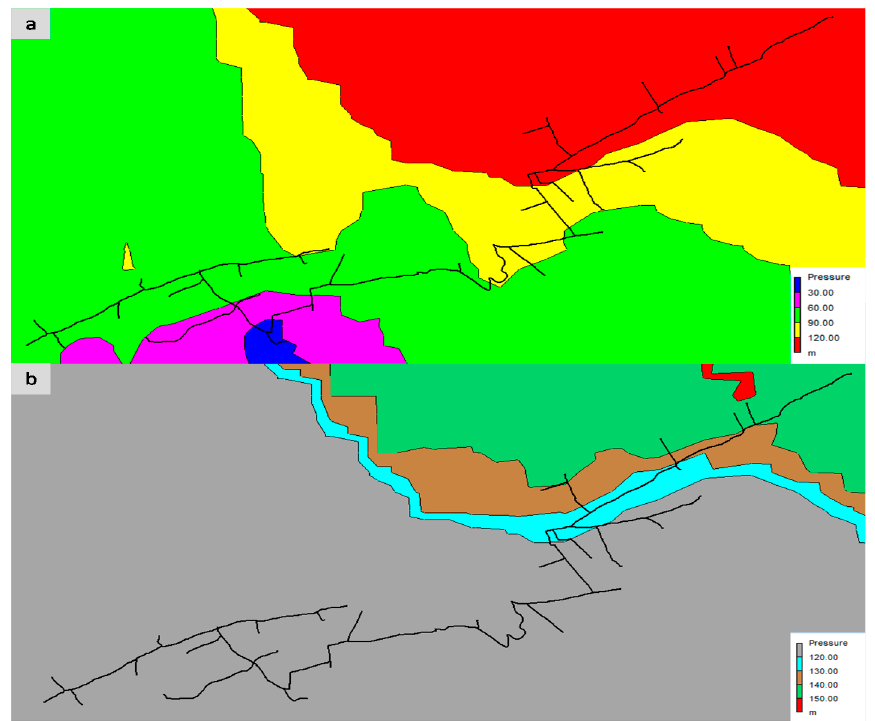
Figure 6. Vallada irrigation system: ( a ) pressure map in irrigation system; ( b ) detail of the area with higher pressures.